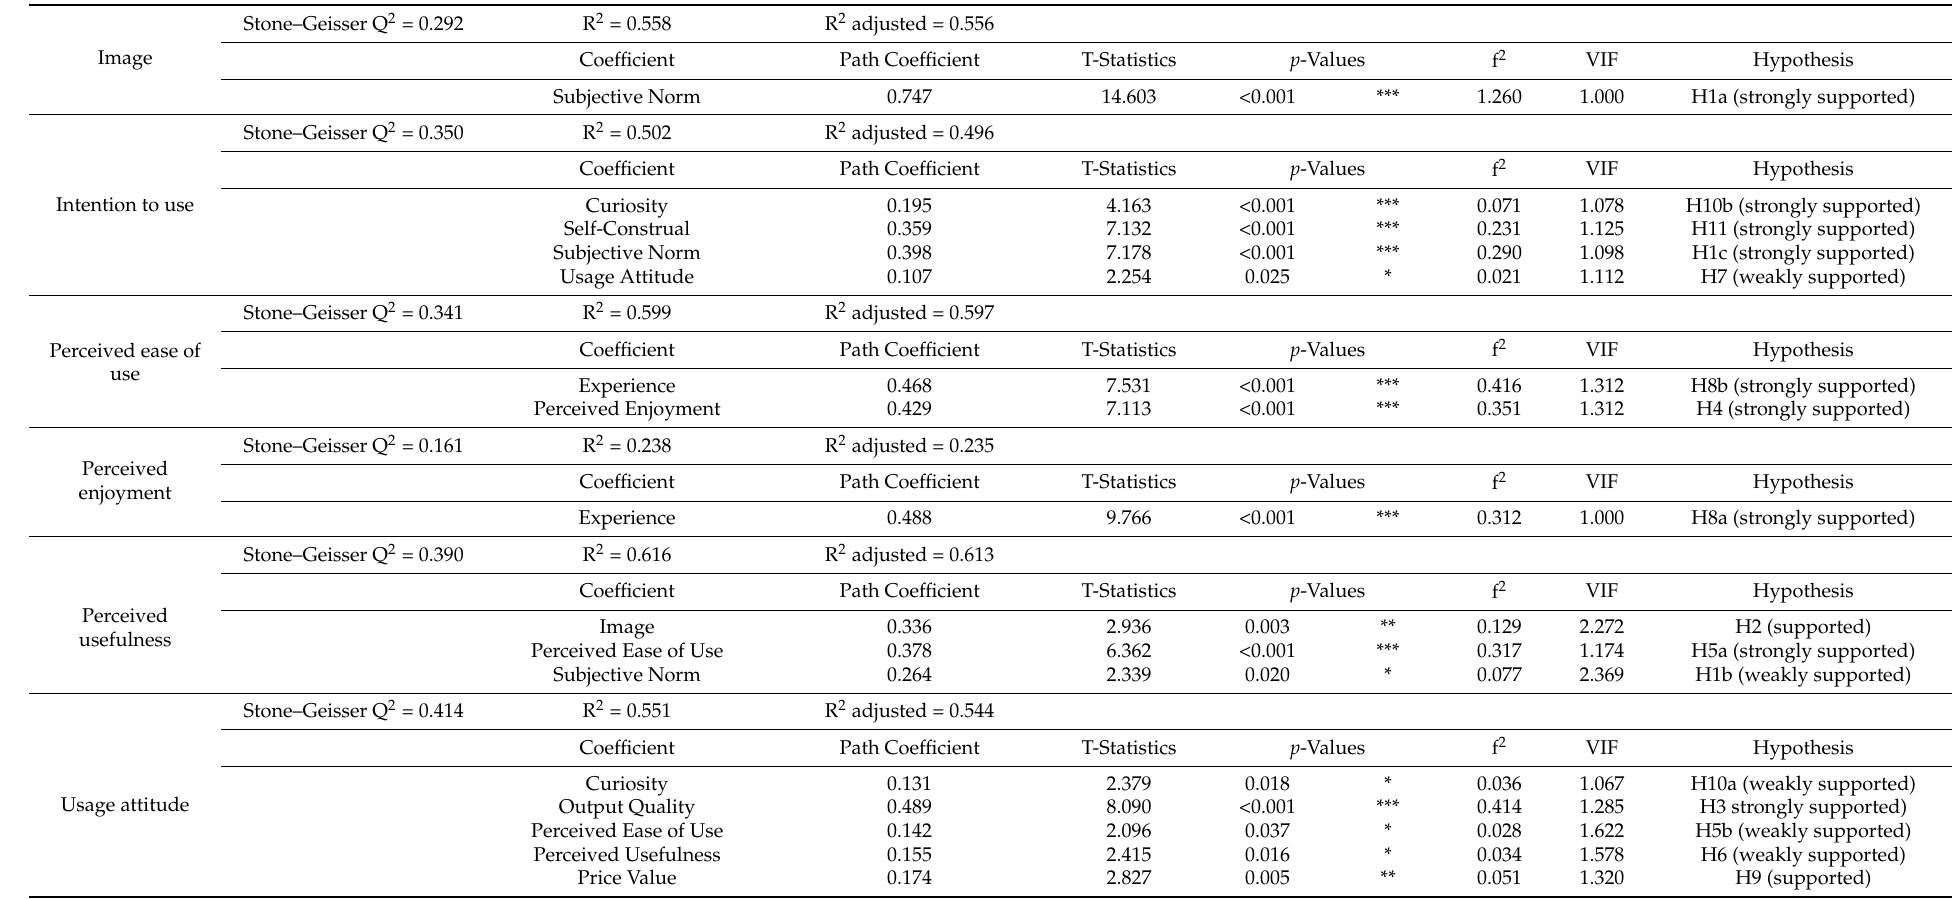
Table 4. Q 2 , R 2 , path coefficient, T-statistics, p -values, f 2 ,